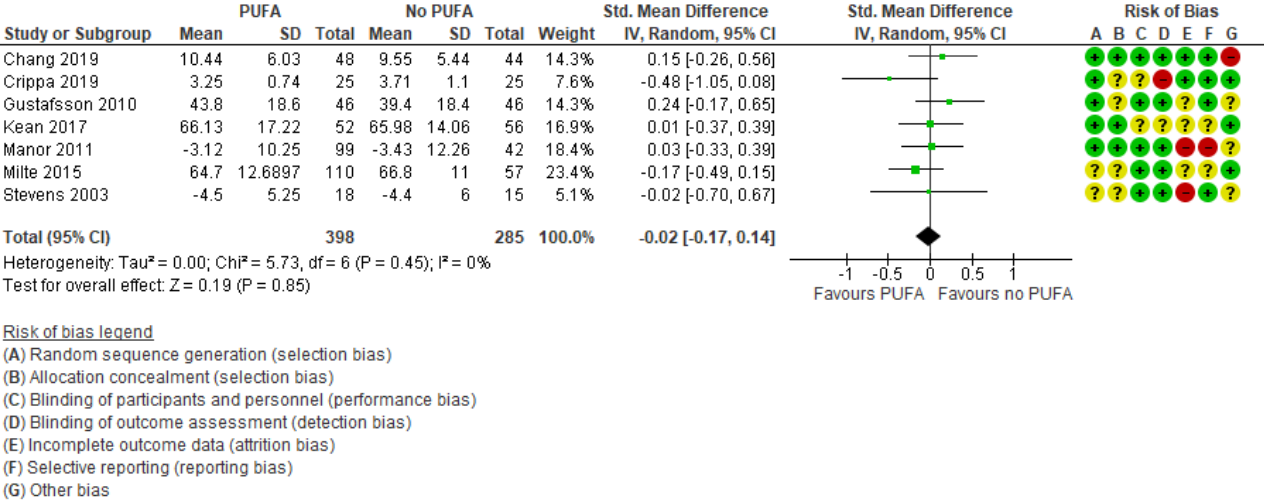
Figure 6. Forest plot of comparison: PUFA vs. placebo, outcome: teacher-reported behavioral difficulties (end of treat- ment). Green square indicates summary estimates of the individual studies. Black diamond indicates total summary effect estimate.